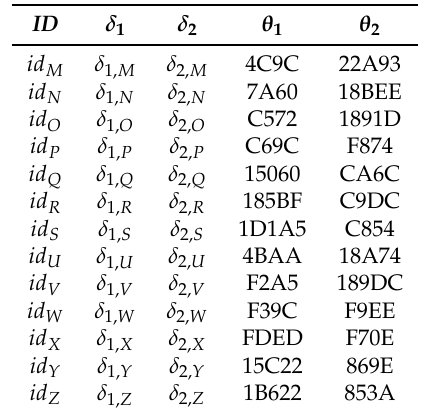
Table 10. Disguised Object Order Decryption by the